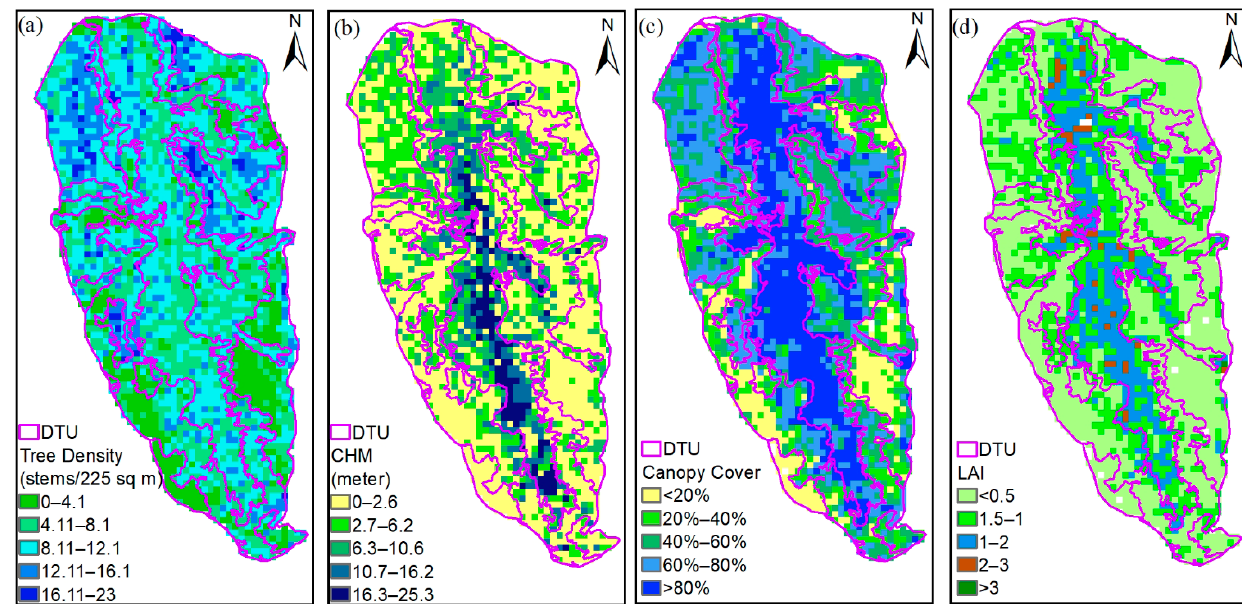
Figure 5. Distribution of vegetation characteristics in study catchment: ( a ) Tree Density (TD), ( b ) Canopy Height Model (CHM), ( c ) Canopy Cover (CC), ( d ) Leave Area Index (LAI). The pixel size is 15 m × 15 m.